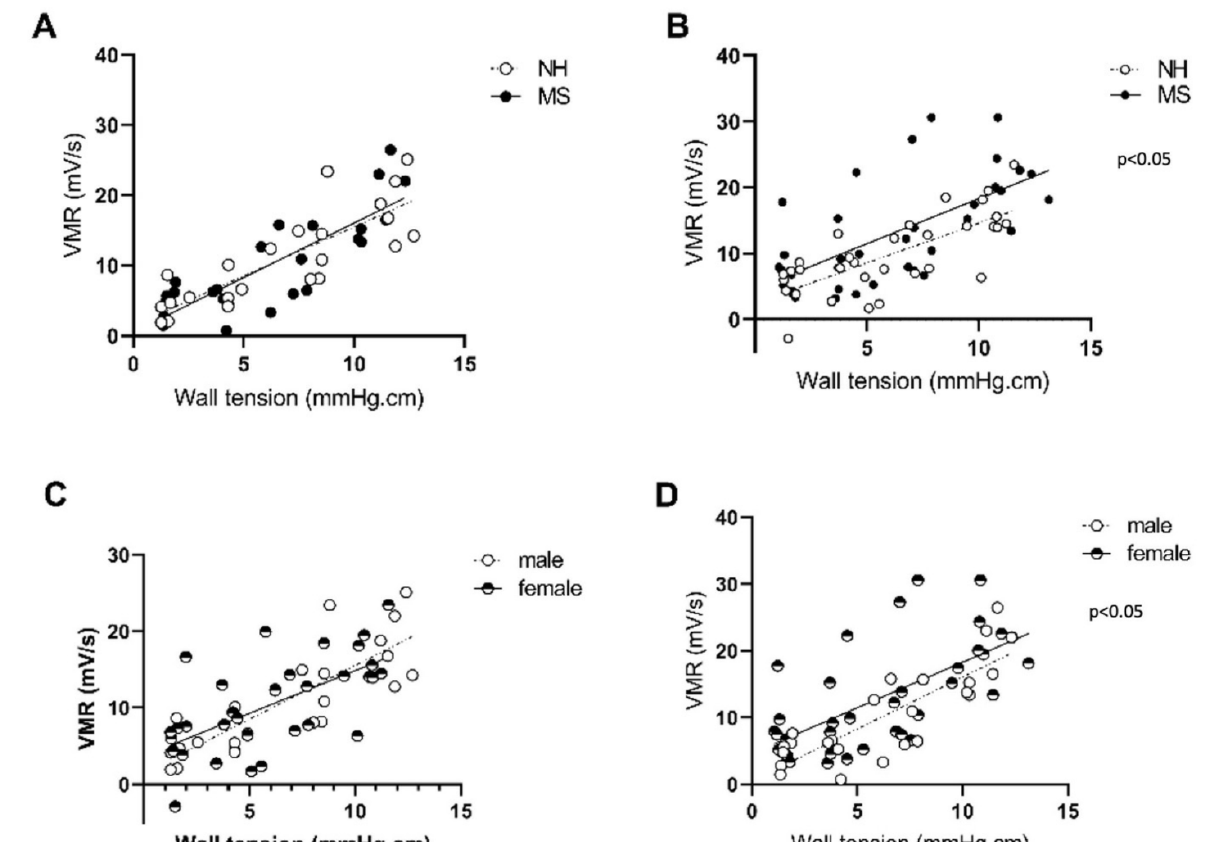
Figure 1. Colonic sensitivity in male and female controls and BBDP-N after maternal separation. Colonic sensitivity was assessed by testing the elevation of linear regression curves using a Fisher test between male NH ( n = 6) and MS ( n = 6) ( A ), female NH ( n = 8) and MS ( n = 9) ( B ), male NH and female NH ( C ) and male MS and female MS ( D ). NH—nonhandled; MS—maternal separation; VMR—visceromotor response. n = 6–10 per group.